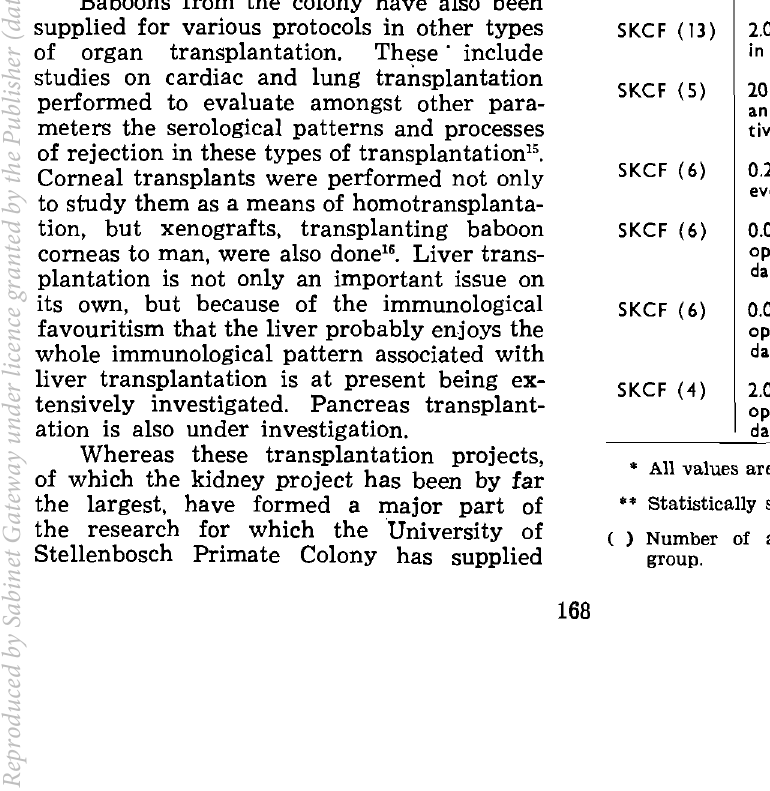
Table I: SURVIVAL TIMES OF UNTREATED CONTROLS AND BIOLOGICALLY TREATED ALLOGRAFTED